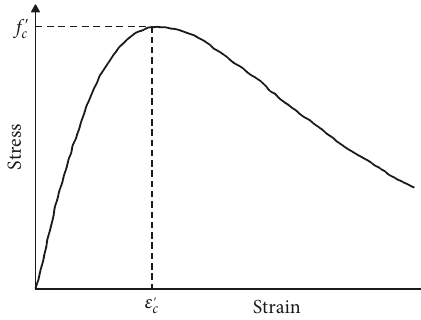
Figure 8: The constitutive model of concrete under uniaxial compression.